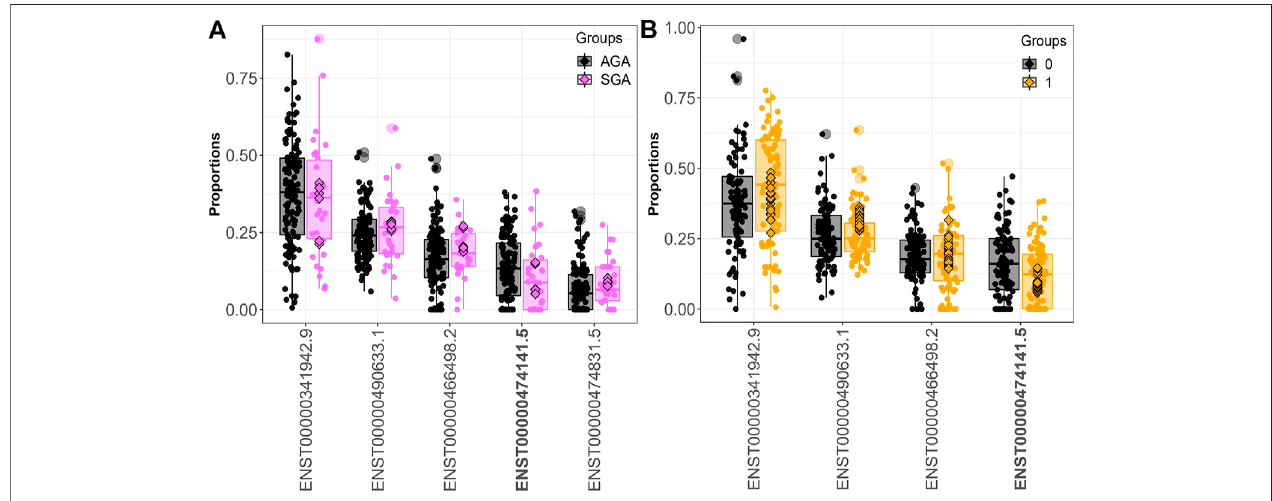
FIGURE3| LAMTOR4 differentialtranscriptusage.Decreasedexpressionofthe LAMTOR4 transcriptENST00000474141.5isobservedinSGAinfantscompared to AGA infants (A) and infants above vs. below the median fetal exposure to (B)